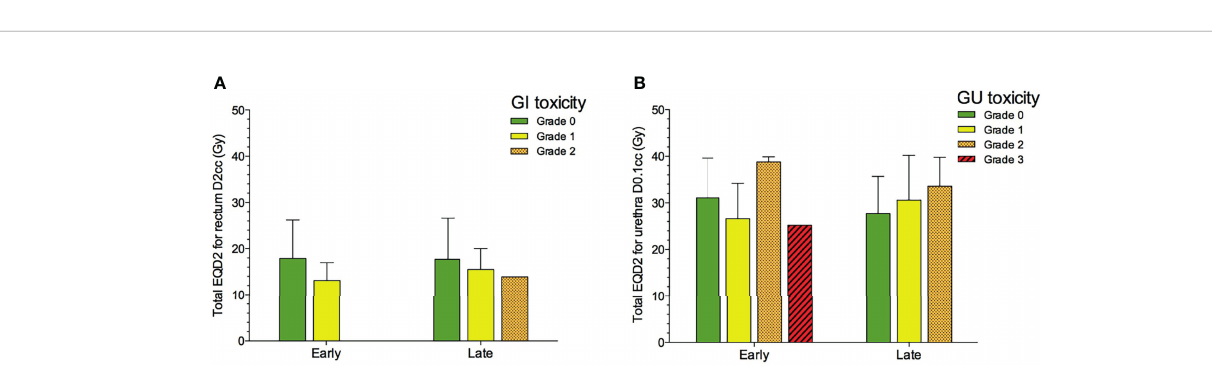
FIGURE 5 | Total EQD2 for rectum D2cc (A) and urethra D0.1cc (B) from the re-irradiation and RTOG-graded gastrointestinal (GI) and genitourinary (GU) toxicity after salvage re-irradiation (n = 33). Bars represent mean values, and whiskers